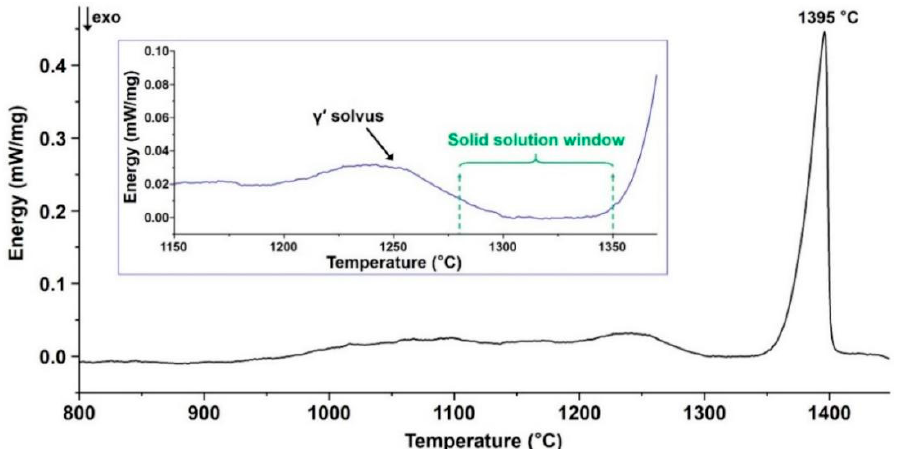
Figure 4. Differential scanning calorimetry (DSC) profile of the as grown Ni-based single crystal superalloy. The inset is a zoom-in of the curve showing details of the solid solution window.